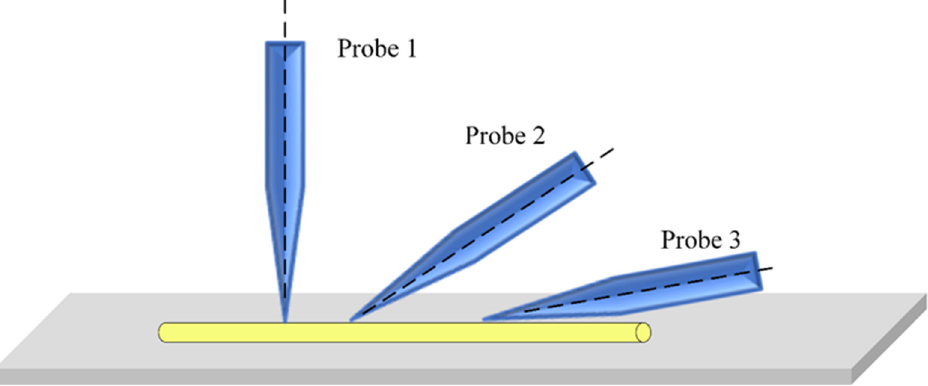
Figure 3. Force interaction between probe and nanorods with different interaction angles.